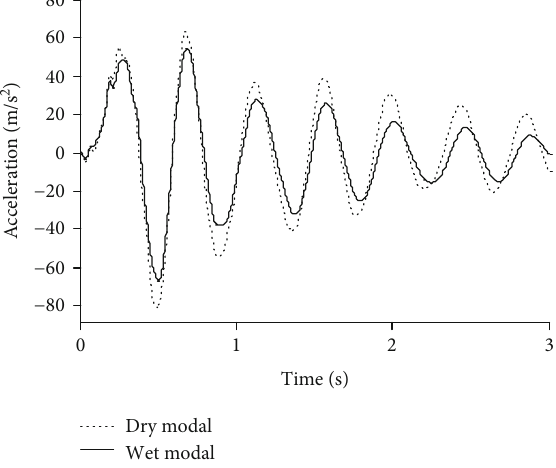
Figure 10: Transient response of acceleration at wing